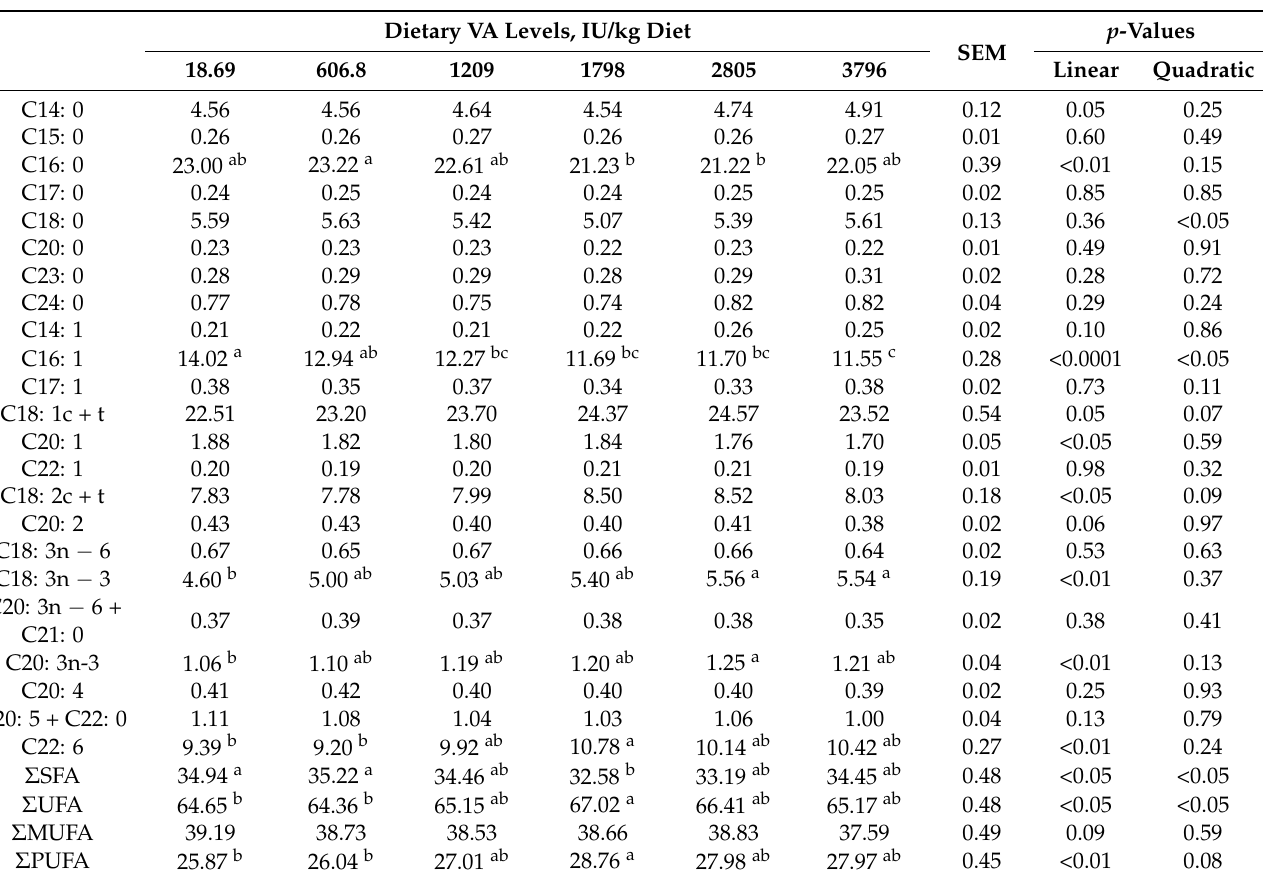
Table 5. Effect of dietary vitamin A on the fillet fatty acid (FA) profile (% of total FA methyl esters) of on-growing grass carp 1 . Dietary VA Levels, IU/kg Diet